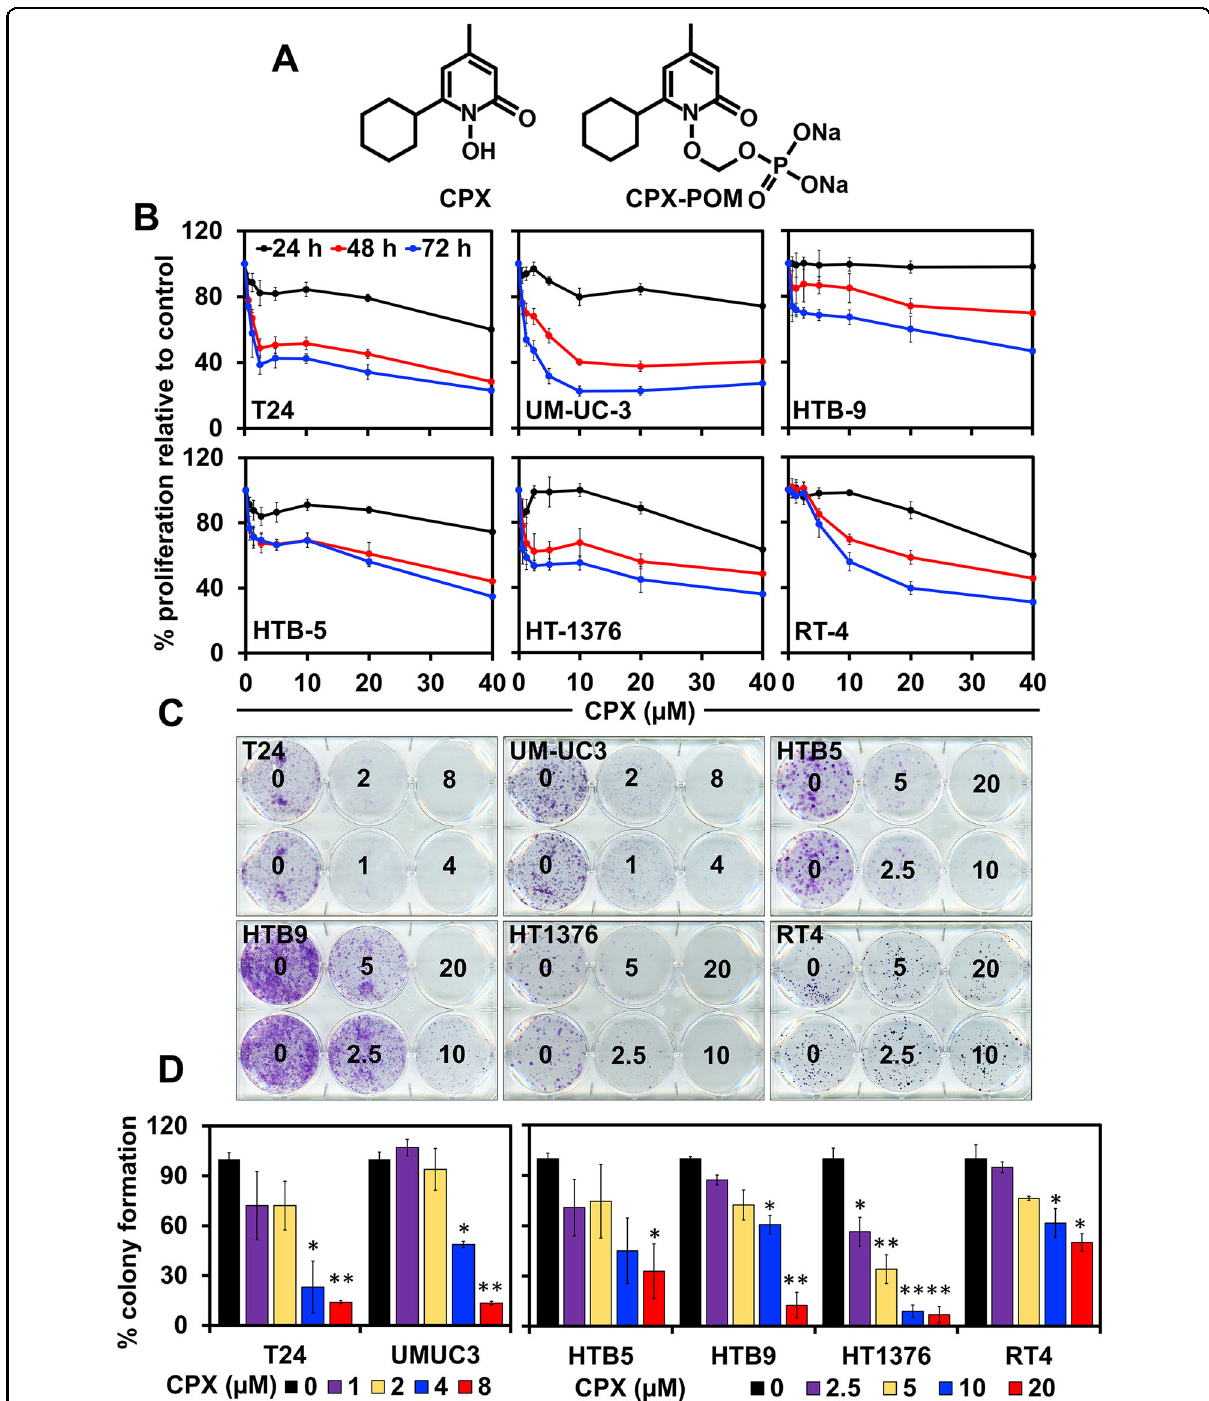
Fig. 1 CPX inhibits proliferation and colony formation in bladder cancer cells. A Chemical structures of CPX and CPX-POM. B CPX inhibits proliferation of bladder cancer cell lines (T24, UM-UC-3, HTB-9, HTB-5, HT-1376, and RT-4). Cells were incubated with increasing concentration (0 – 40 μ M) of CPX for up to 72 h. The treatment showed a signi fi cant dose and time-dependent decrease in cell proliferation when compared with untreated controls in the bladder cancer cell lines. C CPX inhibits colony formation. Cells were incubated with 0 – 20 μ M CPX for 48 h and allowed to grow into colonies for 10 d. Incubation with CPX inhibits clonogenicity and number of colonies in bladder cancer cell lines ( D ).